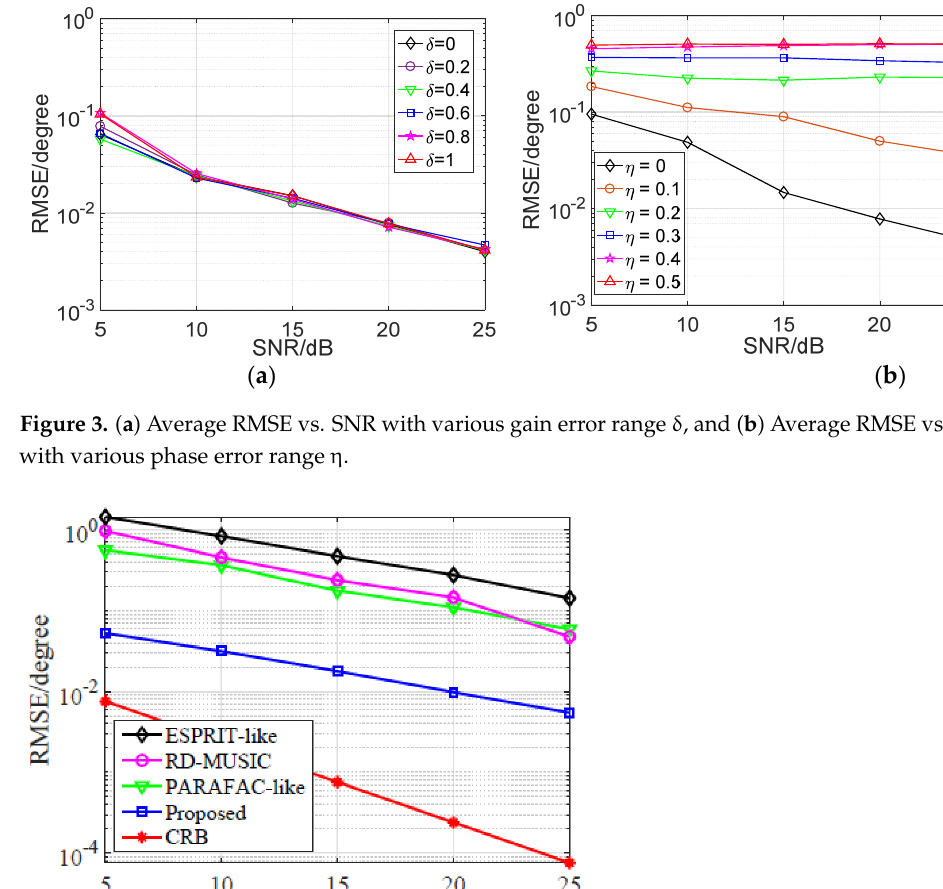
Figure 3. ( a ) Average RMSE vs. SNR with various gain error range δ , and ( b ) Average RMSE vs. SNR with various phase error range η .